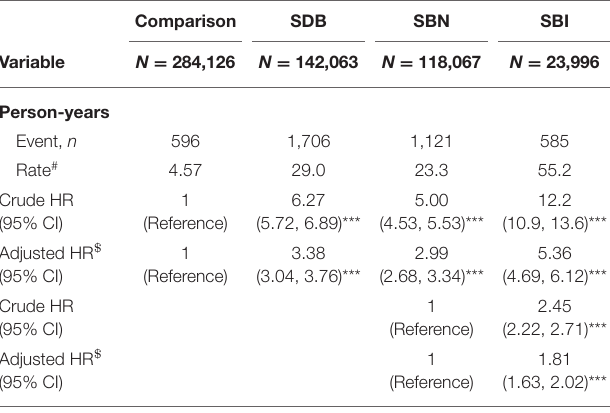
TABLE 4 | Incidence of suicidal drug overdose (per 10,000 person-years) and hazard ratios estimated through the Cox method in patients with SDB with or without head